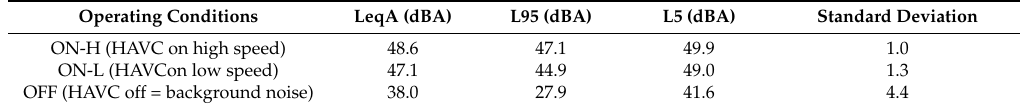
Table 1. Acoustic measurements in an open-plan